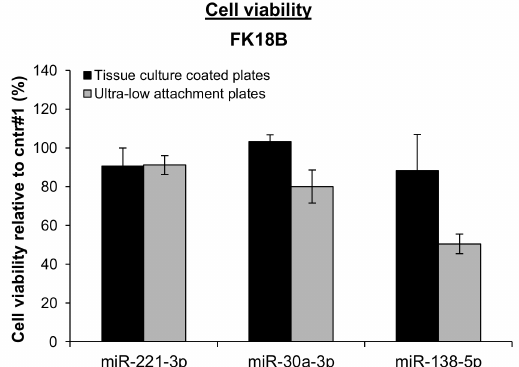
Figure 5. E ff ect of miRNAs on adherent and anchorage-independent growth of late passage FK18B cells. Cell viability of late passage FK18B cells upon ectopic expression of miR-221-3p, miR-30a-3p, and miR-138-5p was measured in adherent tissue culture coated plates and ultra-low attachment plates and standardized against miRNA mimic negative control #1. Mean and standard errors of three independent experiments are